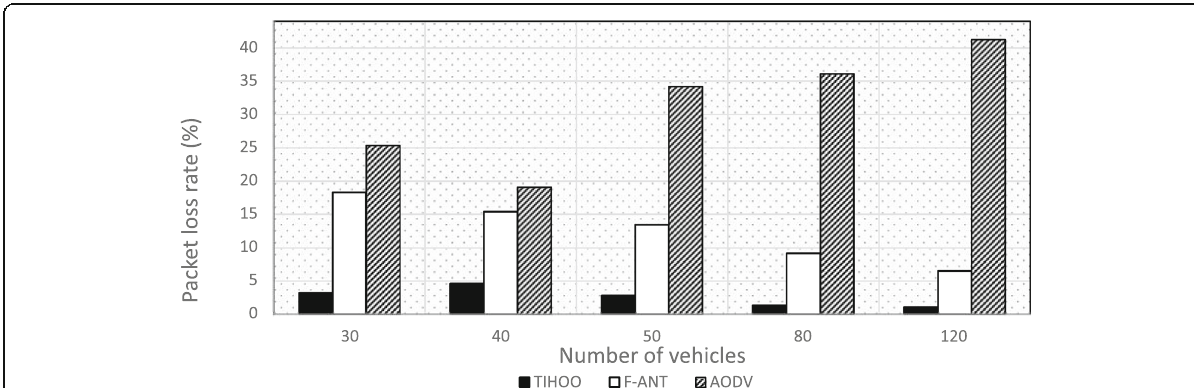
Fig. 10 Packet loss rate based on number of vehicles. The packet loss rate values of TIHOO, F-ANT and AODV protocols for various numbers of vehicles. Loss of data packets was partly due to packet collision, link failure, insufficient bandwidth, overhead of buffer, and etc. In TIHOO, the fitness function of the CS algorithm is configured based on such parameters as route lifetime and its reliability. Employing these factors contributes to the selection of more stable with fewer cases of link failures which affects the packet losses as well. Moreover, accounting for the available buffer for selection of a less congested route is very effective. Less congestion is synonymous with fewer packet